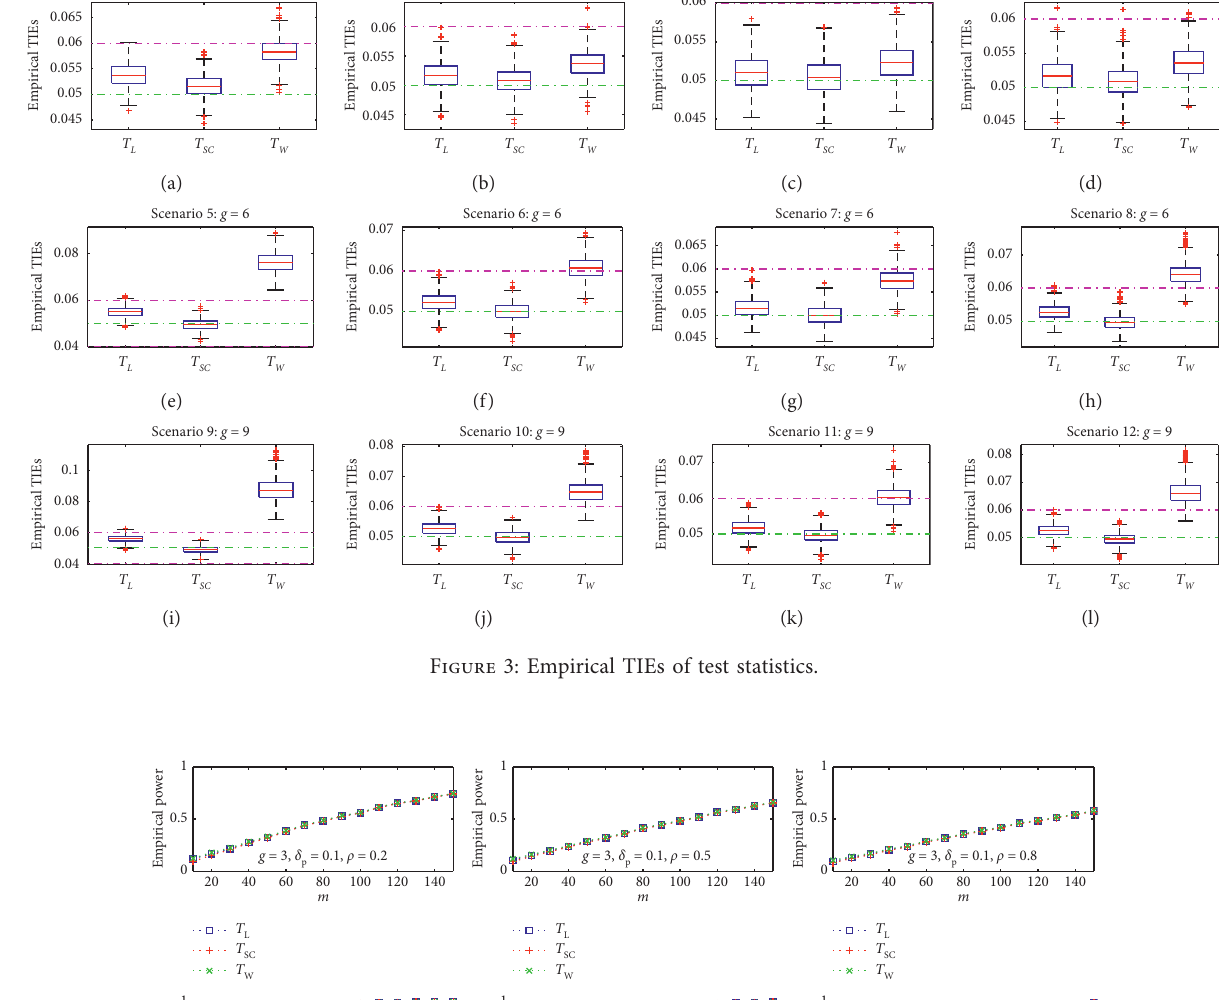
Figure 3: Empirical TIEs of test statistics.